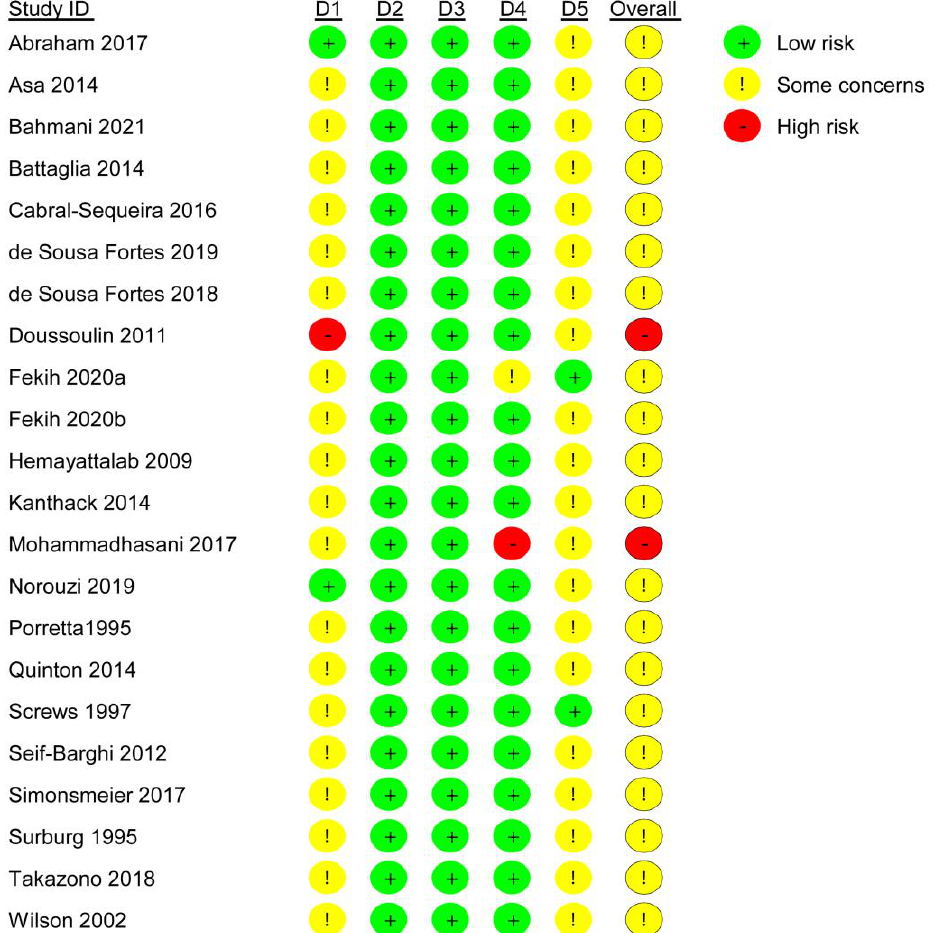
Figure 2. Risk of bias rating for each study. Legend: D1 = Randomization process, D2 = deviations from intended interventions, D3 = missing outcome data, D4 = measurement of the outcome, D5 = selection of the reported results.